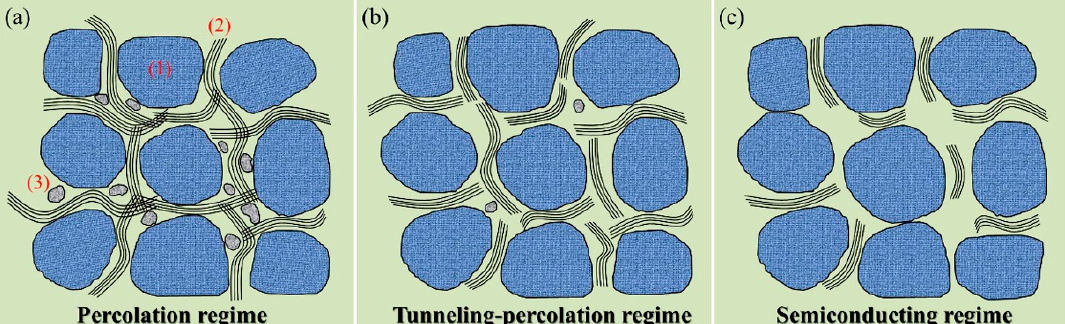
Figure 7. Models for microstructure of PDCs in different conducting regimes: ( a ) the free carbon content is large enough; ( b ) the free carbon content is only higher than the threshold of the tunneling process; ( c ) the free carbon content is lower than the tunneling percolation threshold. (1), (2), and (3) are SiC-based nanodomains, free carbon ribbons, and α -SiC nanoparticles, respectively [34]. Reproduced with permission from Yu Z., Prog. Mater. Sci.; published by Elsevier, 2020.